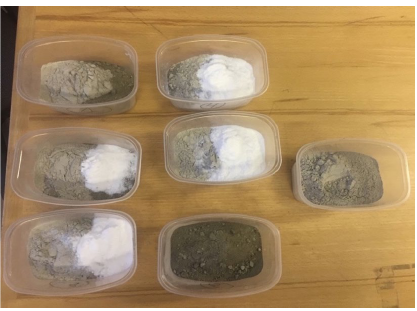
Fig. 1. First steps of mortar